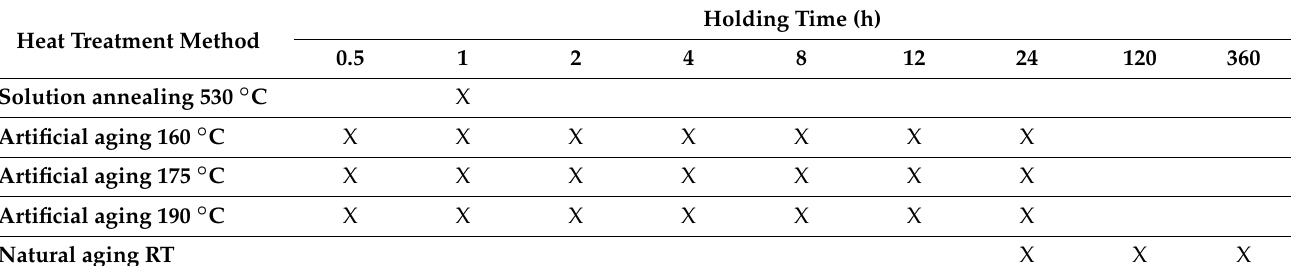
Table 3. Performed heat treatment experiments of base material.